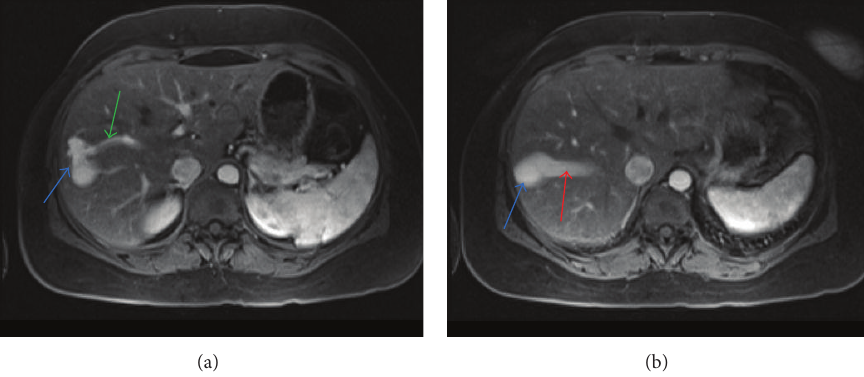
Figure 3: A 45-year-old female with intrahepatic portosystemic venous shunt with associated aneurysms. (a) Contrast enhanced axial VIBE MRI image showing communication between the right portal vein (green arrow) and right hepatic vein through an aneurysm (blue arrow). (b) Contrast enhanced axial VIBE MRI (a few sections cranial to Figure 2(a)) showing communication between the right portal vein and right hepatic vein (red arrow) through a second larger aneurysm (blue arrow). Protocol: Siemens, 1.5 Tesla Avanto MR Scanner, TR = 4.3, TE = 1.91, 3.5 mm slice thickness, Matrix = 192 × 256, with 15mL Gadobenate dimeglumine (Multihance, Bracco Diagnostics Inc.)